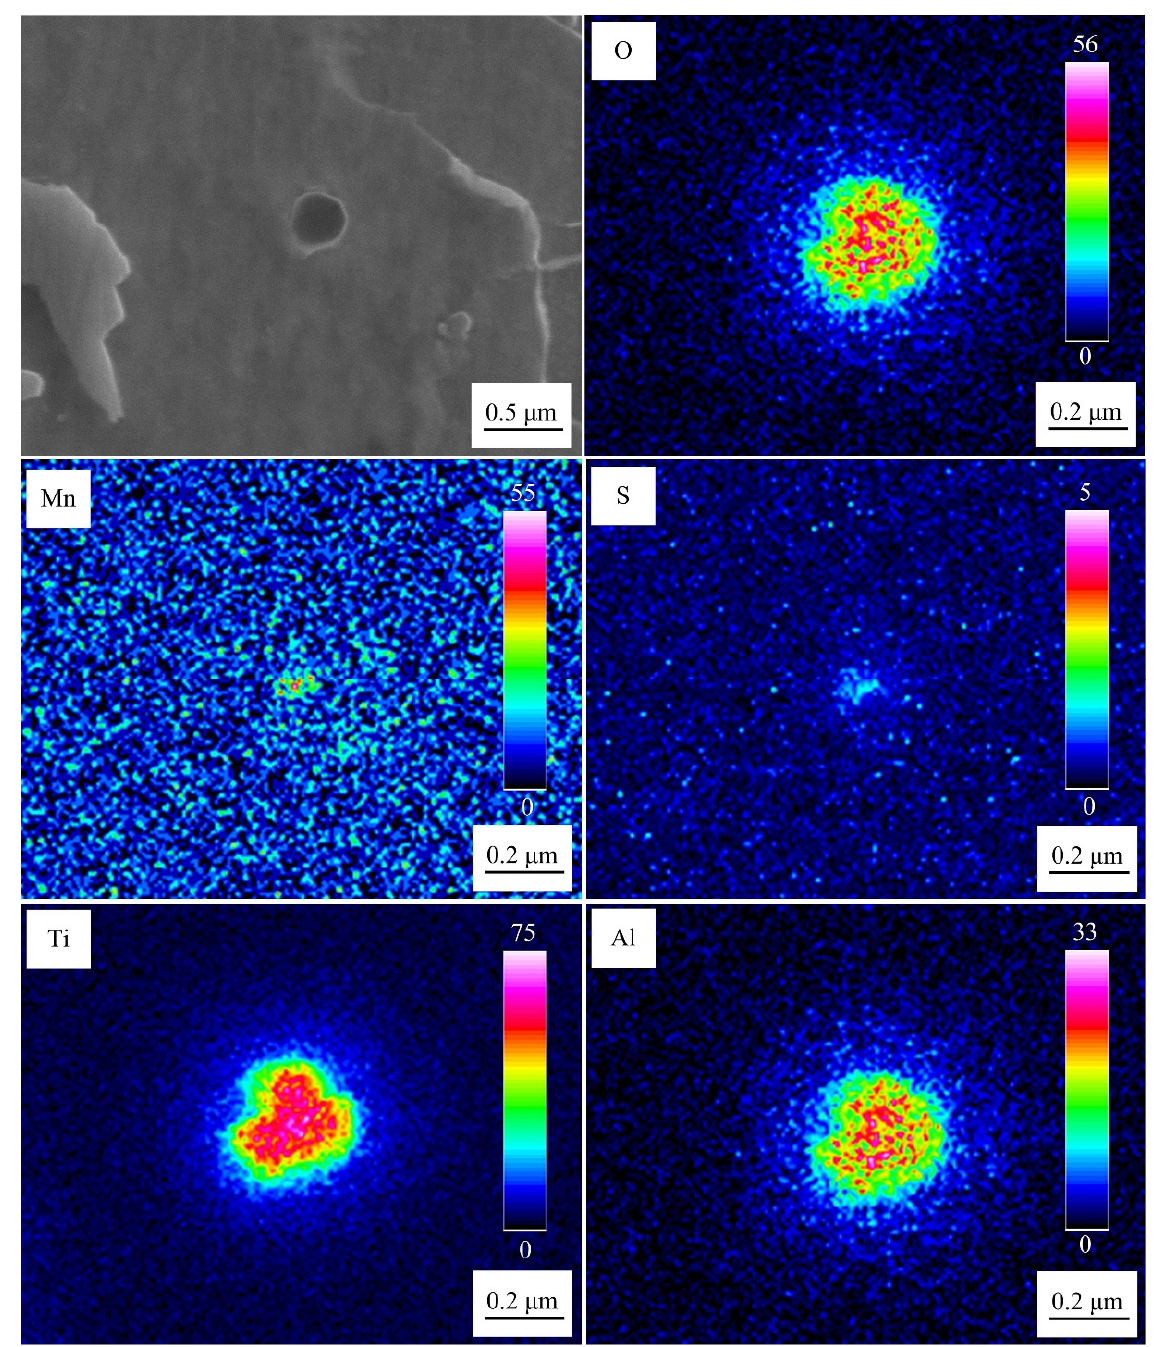
Figure 5. SEM ‐ EDS mapping image of inclusions in the weld metal at the cooling rate of 100 °C/s. Figure 5. SEM-EDS mapping image of inclusions in the weld metal at the cooling rate of 100 ◦